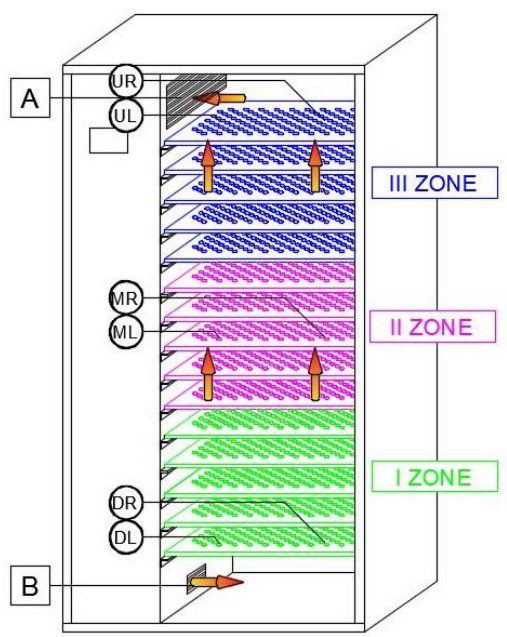
Figure 8. Diagram of the drying chamber with the sampling points marked. A—air inlet; B—air outlet. The arrows indicate the direction of the air flow. Sampling locations: UL—up left, UR—up right, ML—middle left, MR—middle right, DL—down left, DR—down